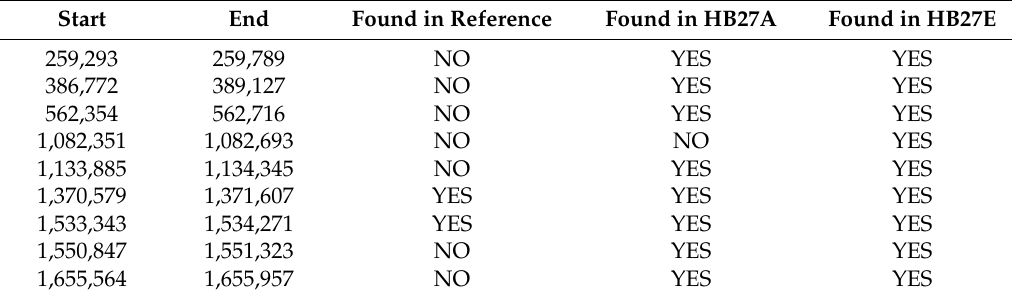
Table 3. Coordinate locations of ISTth7 soft-clipped reads in the chromosome of the reference strain T. thermophilus HB27 (GenBank accession AE017221.1).